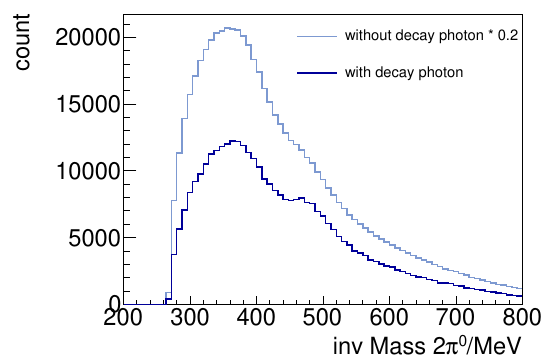
Figure 3. 2 π 0 invariant mass spectrum before and after selecting Σ 0 decay photon.